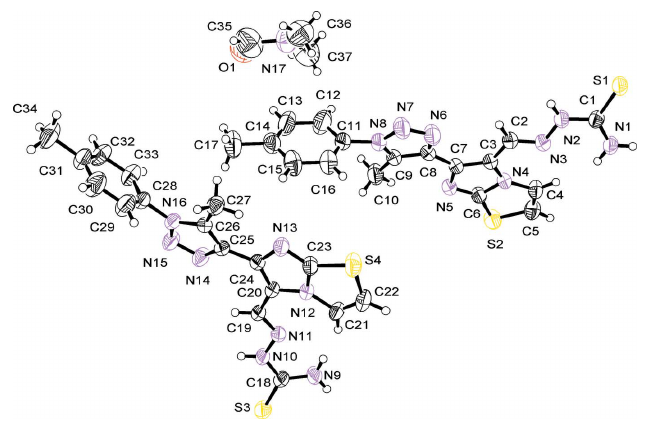
Figure 1 The molecular structure of the title solvate showing 50% displacement